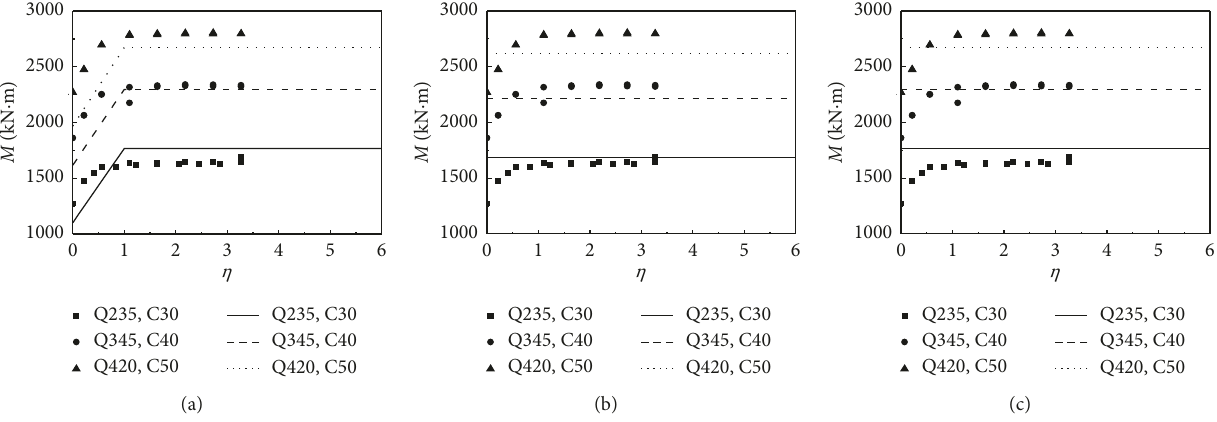
Figure 13: M - ç relationships: comparison between the results of (a) GB 50017 and FEA, (b) BS 5950 and FEA, and (c) Eurocode 4 and FEA.